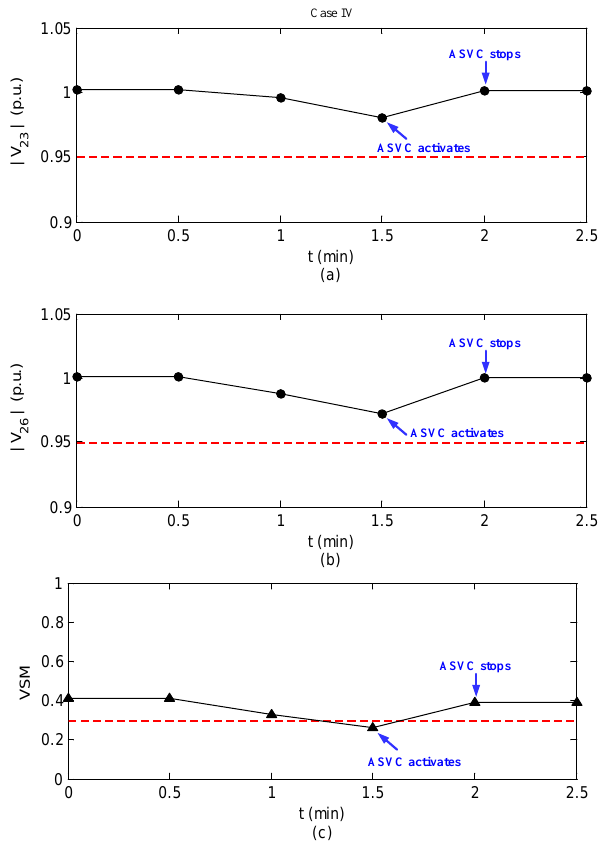
Figure 9. Simulation result of case IV. ( a ) The trace of | V 23 | ; ( b ) The trace of | V 26 | ; ( c ) The trace of VSM. Table 2 summarizes the test results for the above three cases. An inspection from the shown table indicates that both voltage profile and static voltage stability margin are greatly improved after applying the proposed control Table 2. Performance evaluation for the proposed scheme on the IEEE 30-bus system. (p.u.) VSM (p.u.) Case